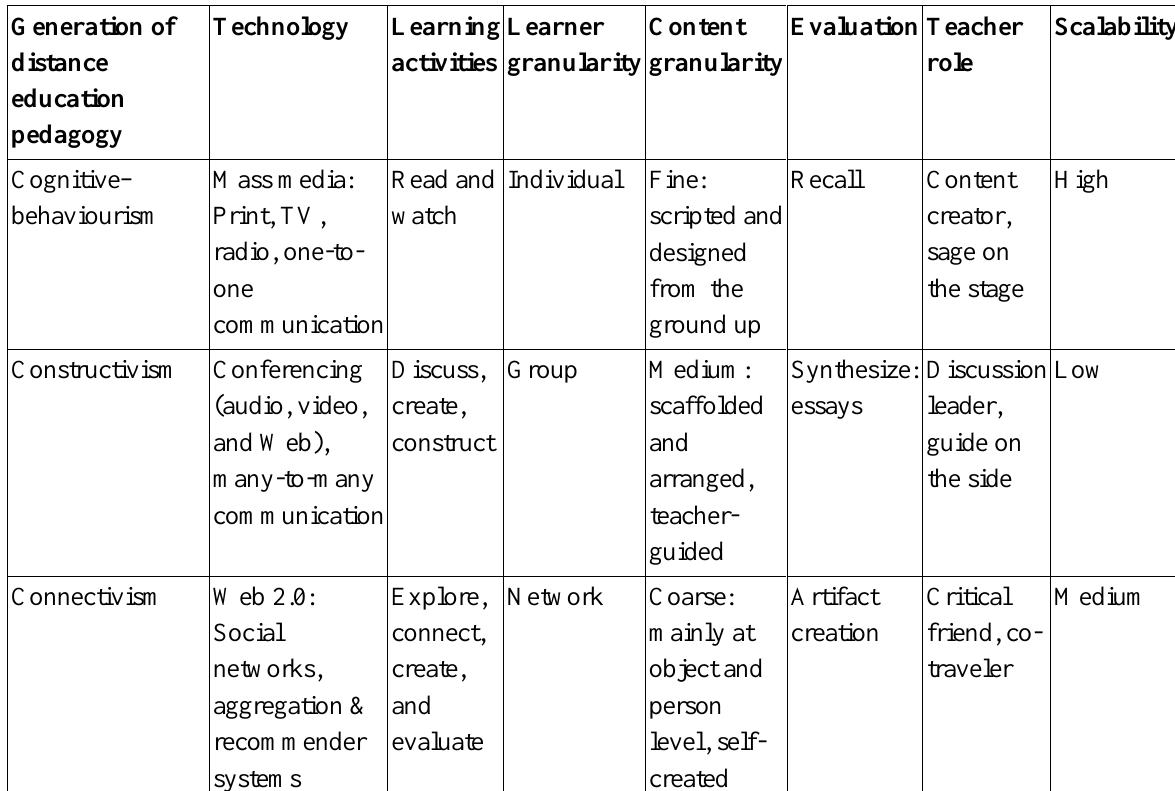
Table 1 Summary of Distance Education